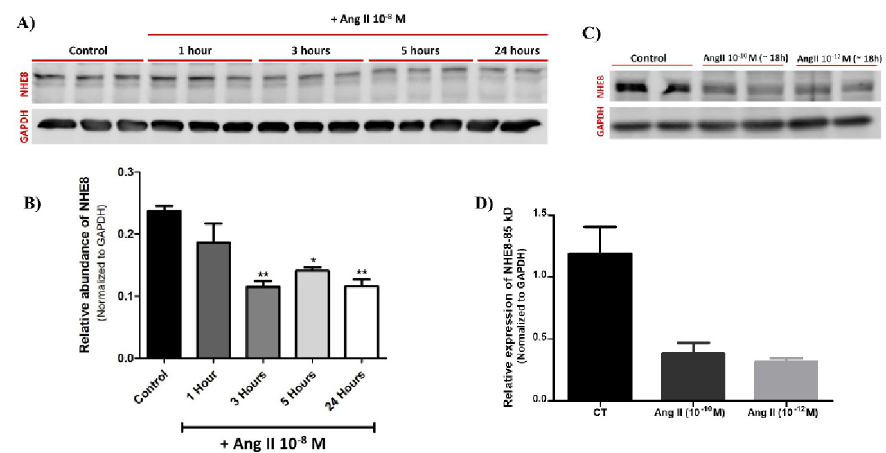
Fig 3. Effect of angiotensin II treatment on NHE8 protein abundance in A549 cells. A concentration of 10 − 8 M of Ang II was added to A549 cells medium for 1, 3, 5, and 24 hours. NHE8 protein abundance, as assessed by western blotting, significantly was decreased following Ang II treatment for 3, 5 (N-3 each) & 24 hours (N-2) (Figures A & B). � P value < 0.05 as compared to control. �� P value < 0.01 as compared to control. Notably, the decrease in NHE8 1 hour (N-3) following the administration of Ang II to A549 did not reach clinical significance. A549 cells were treated overnight (~ 18h) with Ang II at two concentrations (10 − 10 M and 10 − 12 M, n = 2 in each), which resulted in decreased NHE8 protein levels as shown by western blot (C) and the relevant quantification after normalizing to GAPDH (D). Ang II—Angiotensin II. CT—Control. NHE—Na+/H+ Exchanger. GAPDH—Glyceraldehyde 3- phosphate dehydrogenase. The bars represent mean ±